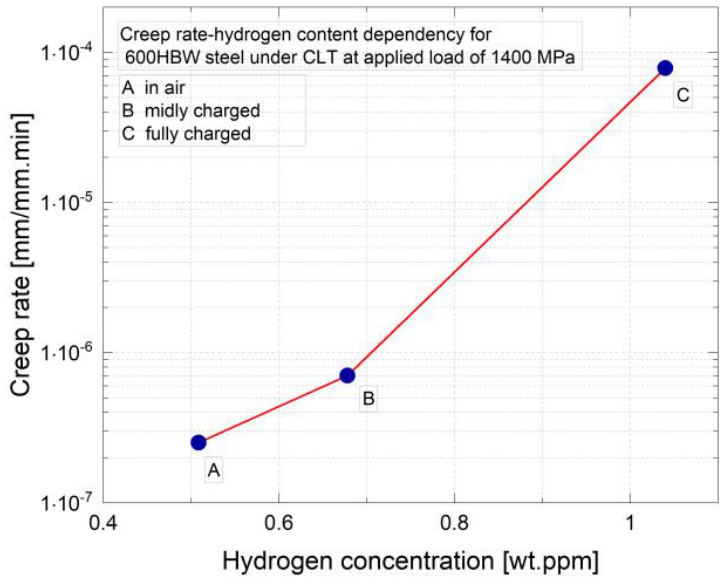
Figure 12. Creep rates in CLT under applied stress of 1400 MPa as a function of measured hydrogen concentration.